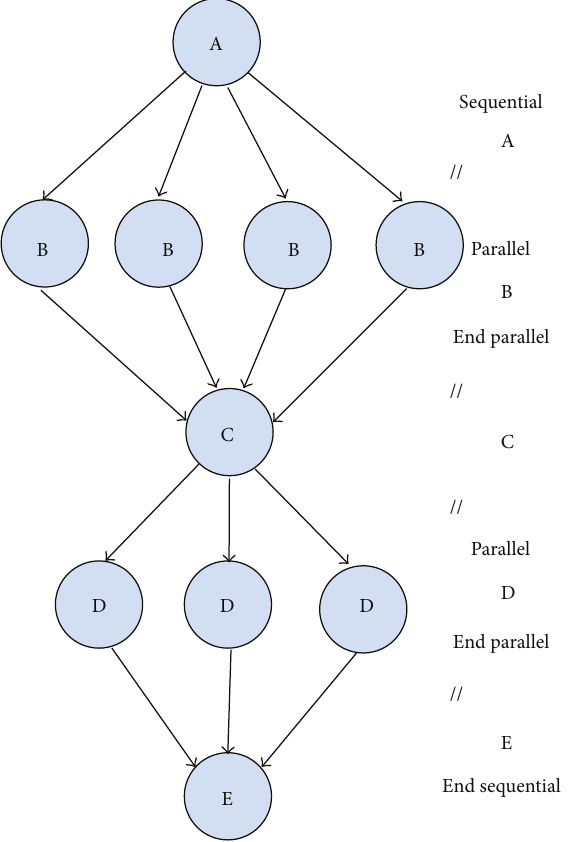
Figure 4: Pseudocode based program model for large-scale scien- tific computing.